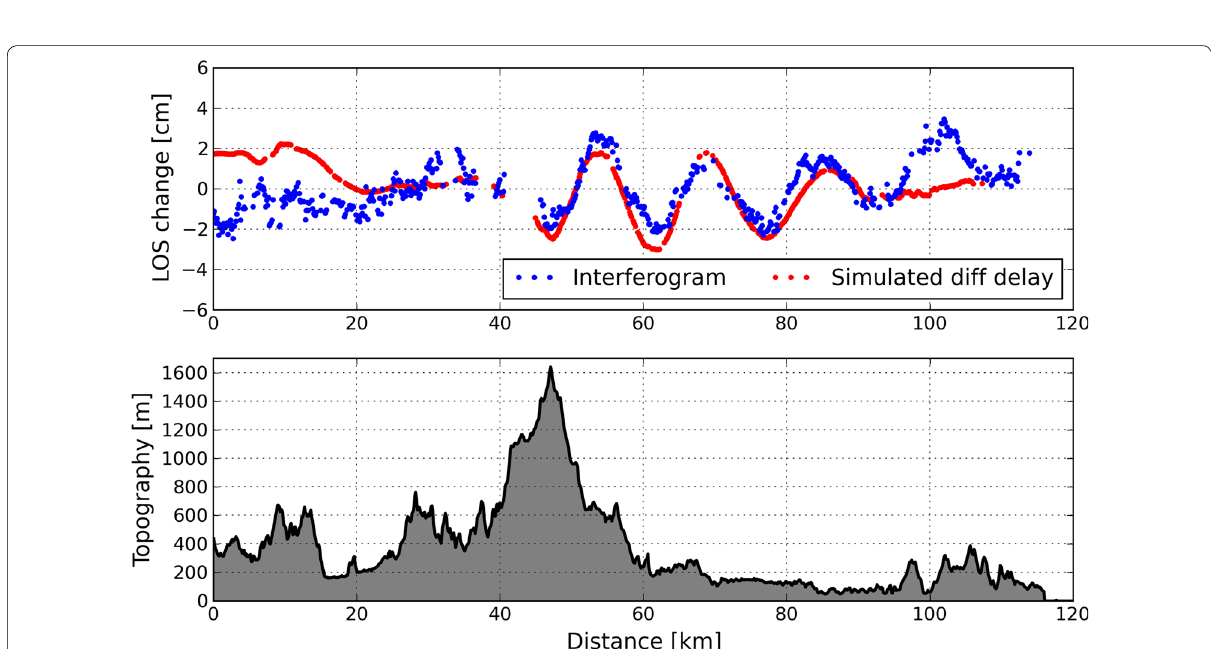
Fig. 9 Phase variation profiles in Tohoku. ( Top ) profiles of observed phase variation ( blue ) and simulated propagation delay ( red ) along gray (InSAR) and black (WRF) lines shown in Fig. 4b. Both lines in Fig. 4b passed through the location of the top of the Kurikoma Mountain. ( Bottom ) a profile of topography from GSI 10 m